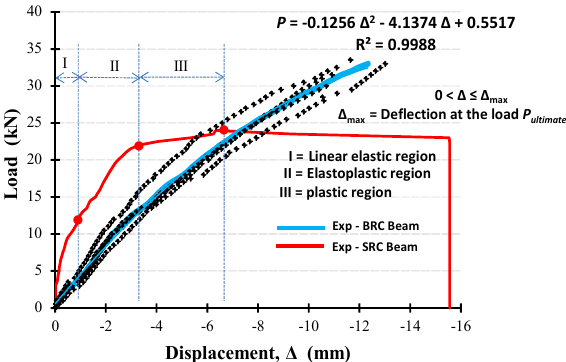
Figure 7. The load vs. deflection relationship of the BRC beam from experiment [14].